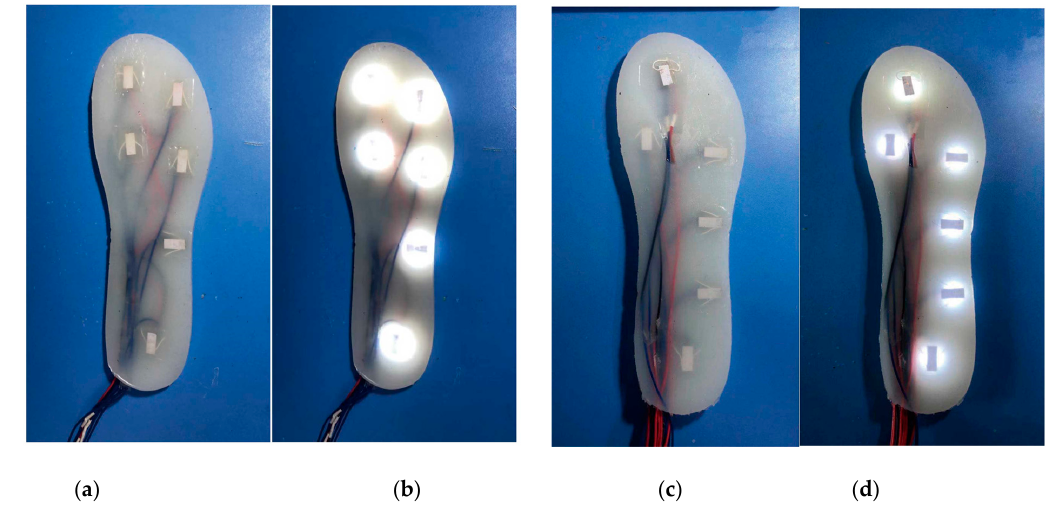
Figure 7. Two insole solutions for the right foot insole. ( a ) Insole solution No. 1 without power ( b ) Insole solution No. 1 with power ( c ) Insole solution No. 2 without power ( d ) Insole solution No. 2 with power.